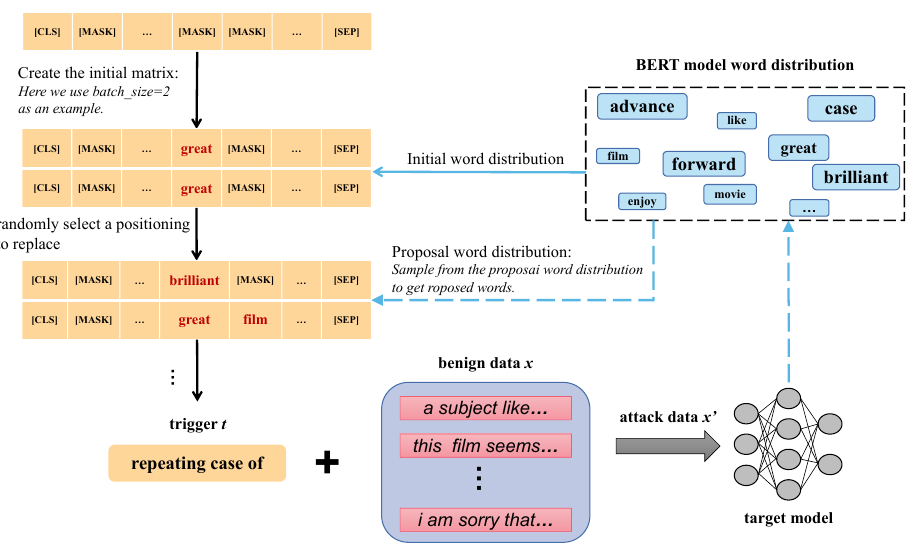
Figure 4. Overview of our attack. At each step, we concatenate the current trigger to a batch of examples. Then, we sample sentences conditioned on the loss value and classification accuracy computed for the target adversarial label over the batch from a BERT language